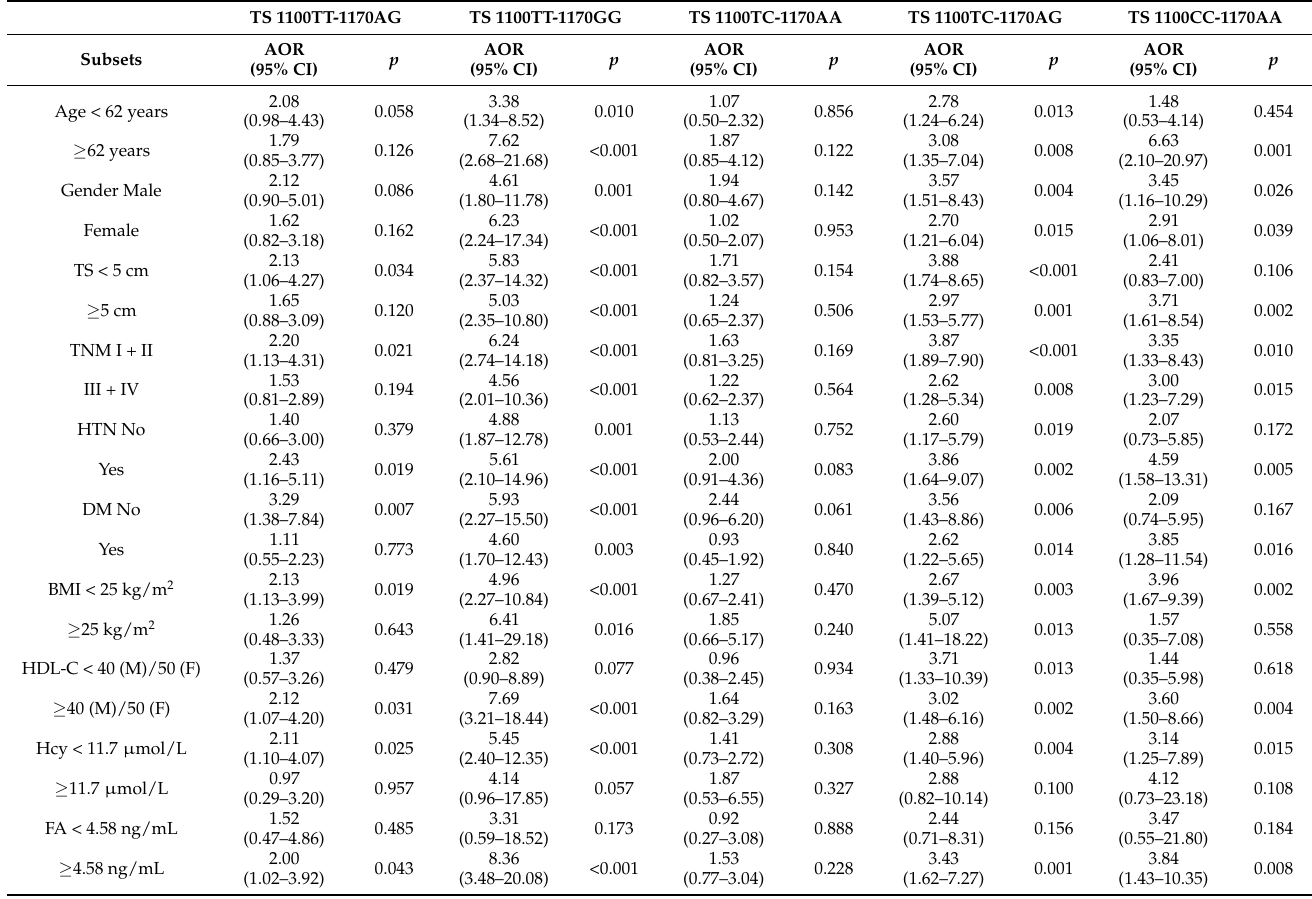
Table 4. Analysis of CRC incidence and association in specific patient